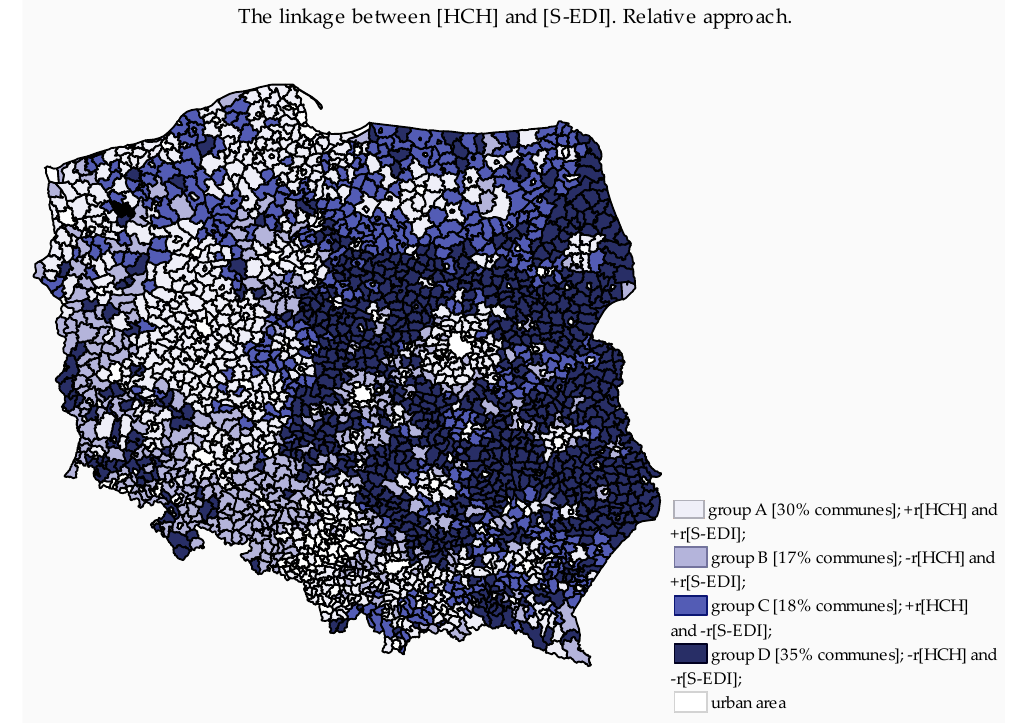
Figure 7. Linkage between the level of human capital in the area of health [HCH] and the level of socio-economic development [S-EDI]. Source: own elaboration.